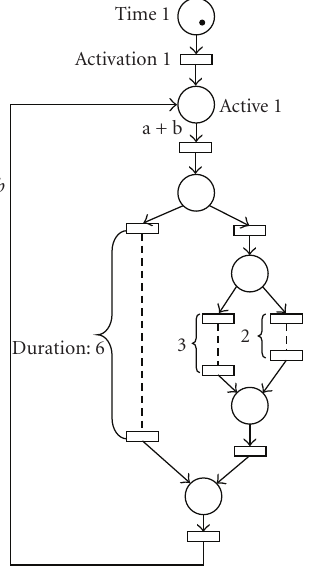
Figure 6: PN model for variable tasks duration.